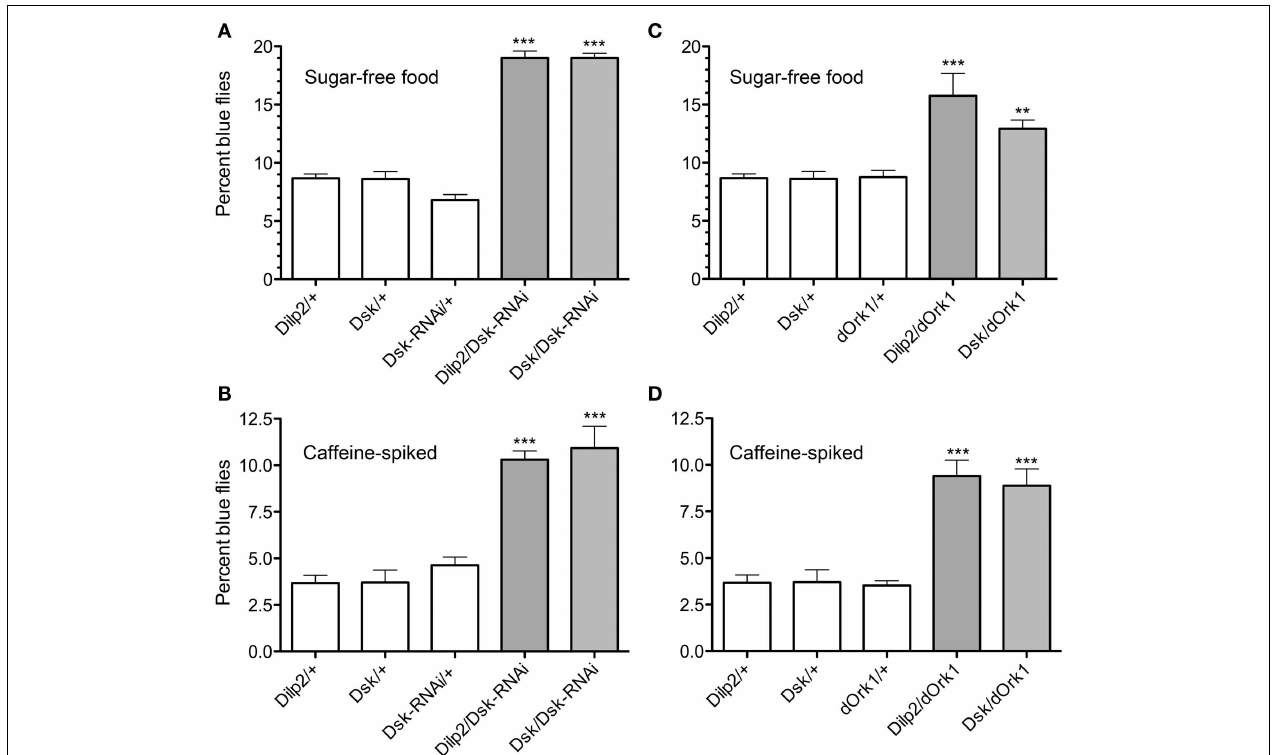
only results with blue non-preferred food; percent flies with blue gut contents were scored. (A) Test of sugar-free food. Flies depleted of DSK by the means of Dsk -RNAi in IPCs (Dilp2/Dsk-RNAi) or in all DPCs (Dsk/Dsk-RNAi) consume sugar-free (blue) food to a greater extent than respective controls (white bars). (B) Test of caffeine-spiked food. Depleting flies of DSK in all DPCs (Dsk/Dsk-RNAi) or in IPCs only (Dilp2/Dsk-RNAi) caused flies to increase their ingestion of caffeine-spiked (blue) food. (C) Electrical inactivation of IPCs signaling in adult flies with dOrk1 ( Dilp2 / dOrk1 ) is sufficient to increase the flies’ intake of sugar-free food. Electrical inactivation of all DPCs (Dsk/dOrk1), also significantly increased this food consumption. (D) Electrical inactivation of IPCs ( Dilp2 / dOrk1) and DPCs ( Dsk / dOrk1) also results in flies that more abundantly feed on caffeine-spiked